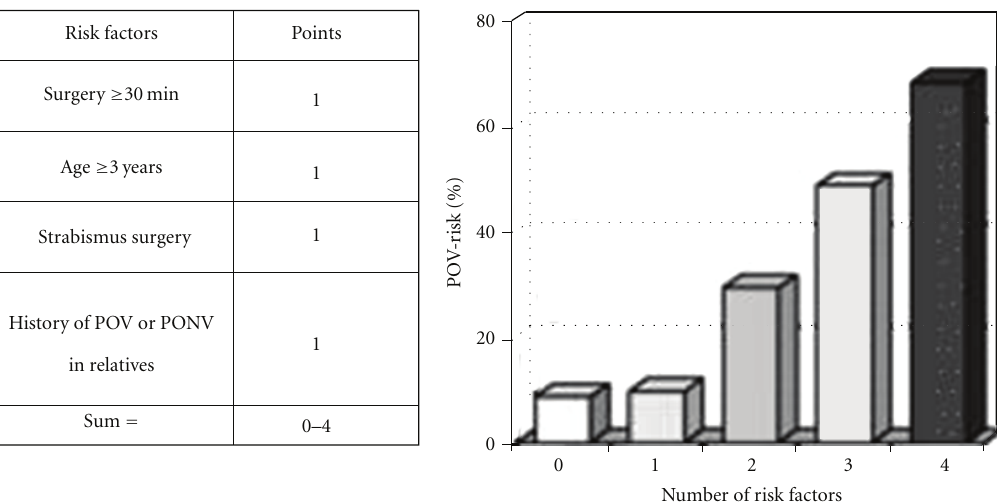
Figure 3: Simplified risk score for POV in children. (Reproduced from the original article by Gan et al.